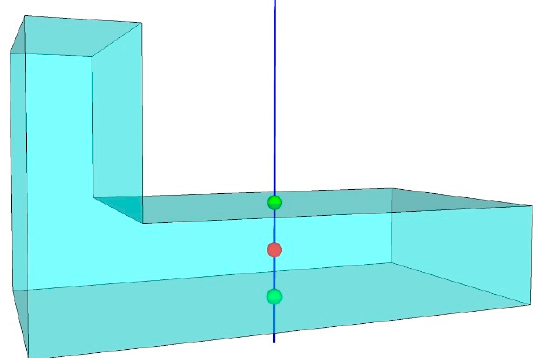
Figure 12. The line-space intersections (green) and the centroid (red).